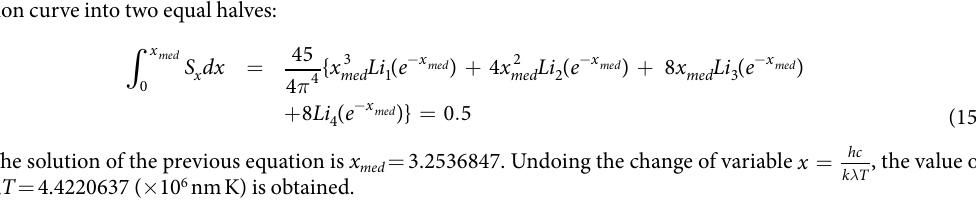
are the same than those required for the energy fractional emissive power, which is translated in much less com- putational power. Figure 2a represents the normalized energy and entropy distributions as well as their corresponding emissive power. Using Equation 14, the Median is determined as the value of x which divides the area under the distribu- tion curve into two equal halves: